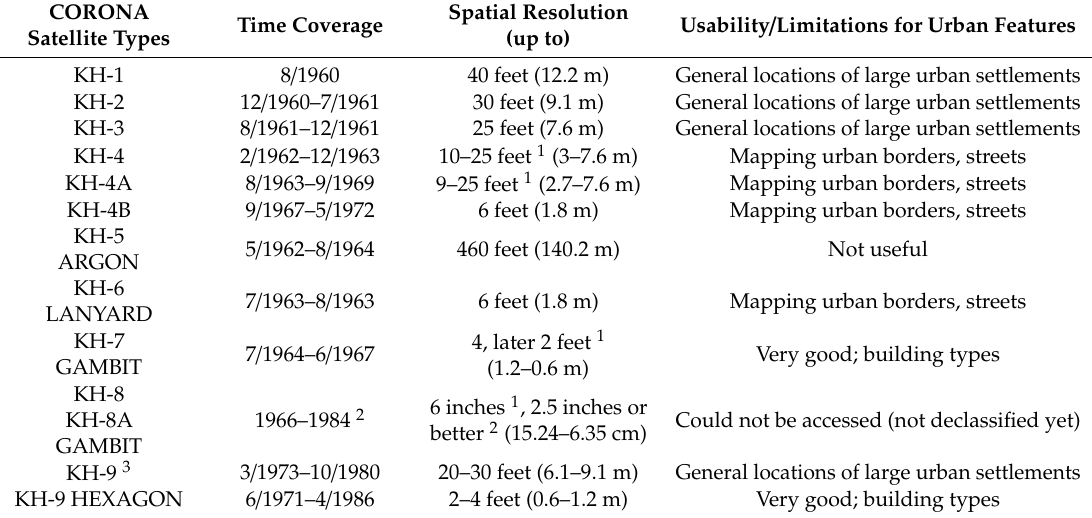
Table 1. Reconnaissance photographic film satellite imagery specifics and usability for visual analysis of urban sprawl (data from USGS Earth Explorer platform, accessed between July and Sept 2020, when not indicated